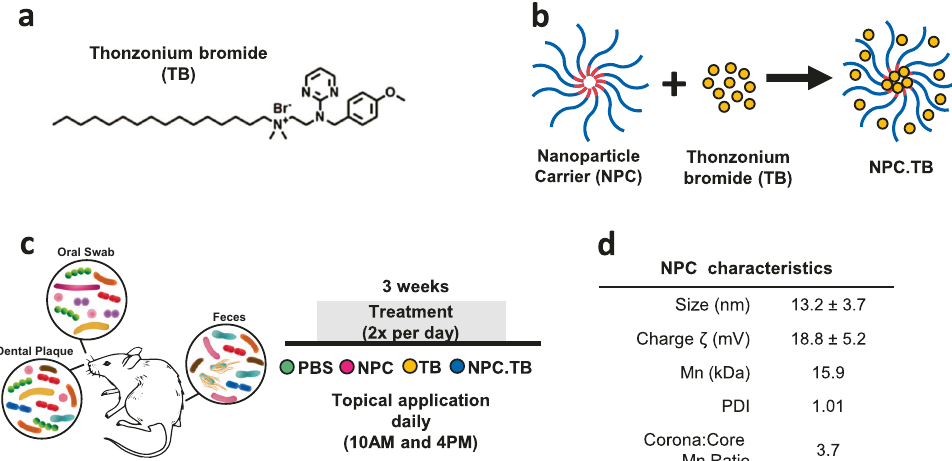
Fig. 1 Animal model and treatment regimen for drug repurposing evaluation. a Thonzonium bromide (TB) chemical structure. b Cartoon illustration of TB-loaded into nanoparticle carrier. c Diagram of the animal experiment indicating the body site microbiome including oral (dental plaque and oral swab) and gut (feces). The treatment was performed twice a day for 3 weeks. Treatment groups included PBS, NPC, TB, and NPC.TB. d Table summarizing the characterization parameters of the NPC used in this study (NP13/3). PBS phosphate buffer saline, NPC nanoparticle carrier, TB thonzonium bromide, NPC.TB TB-loaded nanoparticle carrier, Mn number average molecular weight, PDI Polydispersity